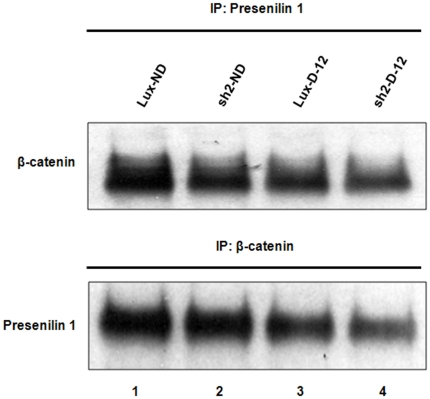
Complexed β-catenin and PS-1 in wild type and HPRT-knockdown SH-SY5Y cells.SH-SY5Y cell proteins were immunoprecipitated by antibody to PS-1 (upper panel) and to β-catenin (lower panel) and reacted with β-catenin or PS-1 antibodies. Un-differentiated control cells transduced by luciferase vector (lane 1), undifferentiated HPRT-knockdown cells (lane 2), 12-day differentiated control cells (lane 3) and 12-day HPRT-knockdown cells (lane 4).